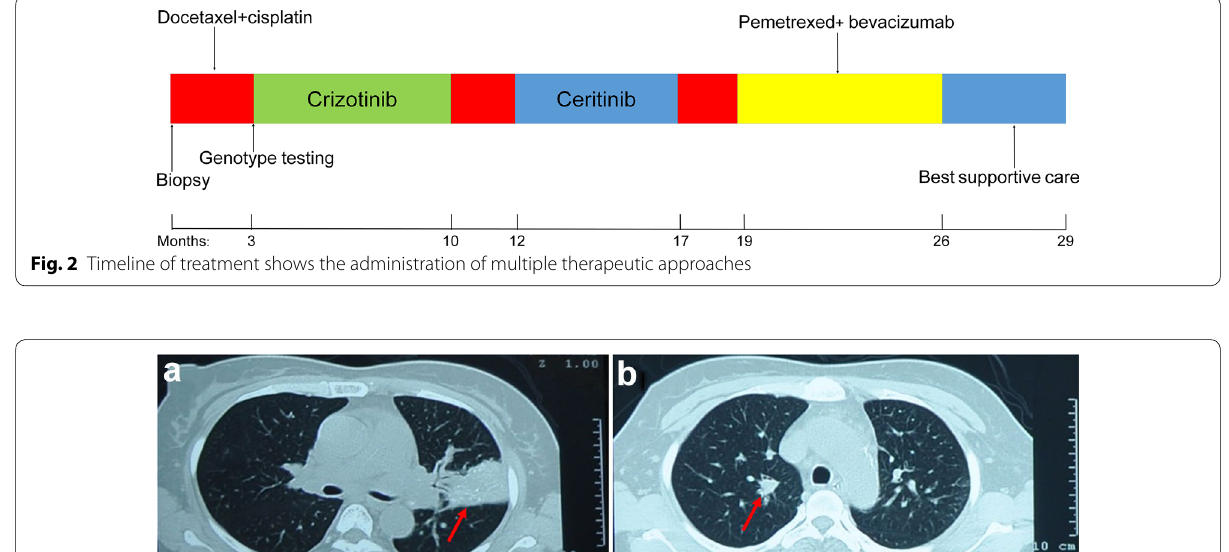
(Fig. 6a, d, g). After the re-biopsy of liver metastasis, three EML4–ALK resistance mutations (C1156Y, D1203N and L1198F) was found. The patient began to receive treat- ment of pemetrexed (500 mg/m 2 D1